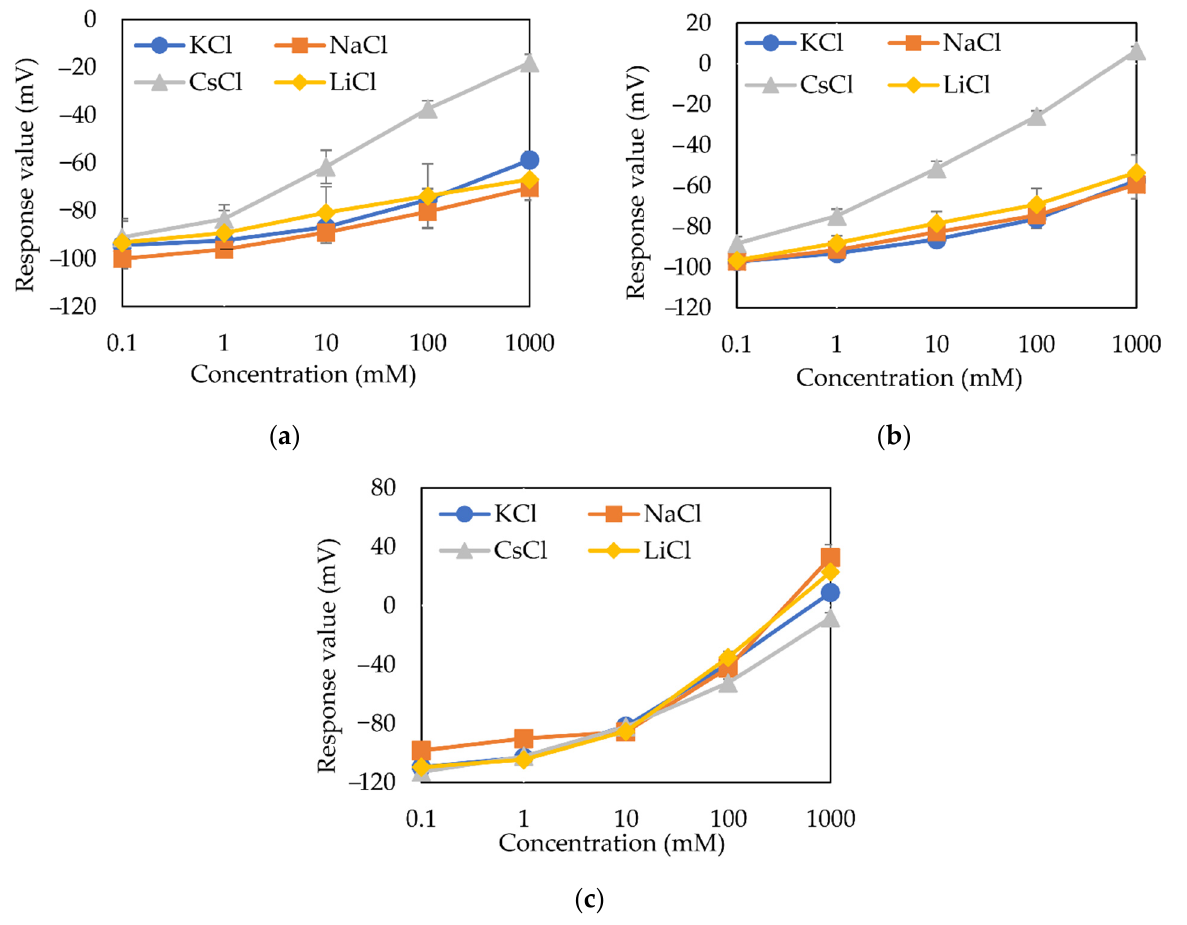
Figure 5. Sensor responses ( V s − V r ) to alkali metal salts samples: ( a ) Blank membrane; ( b ) low PADE concentration (0.03 mM); ( c ) high PADE concentration (30 mM). Table 4. The slope for KCl, reference potential ( V r ), and selectivity coefficients of the